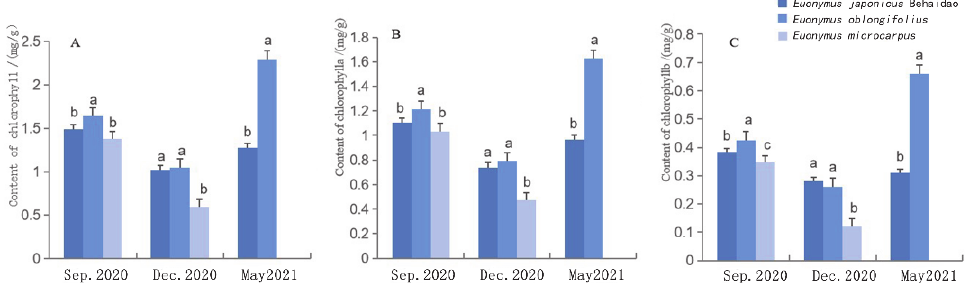
Figure 4. Changes in pigment content in three Euonymus species. ( A ) total chlorophyll content; ( B ) chlorophyll a content; ( C ) chlorophyll b content; a, b and c represent significant differences.